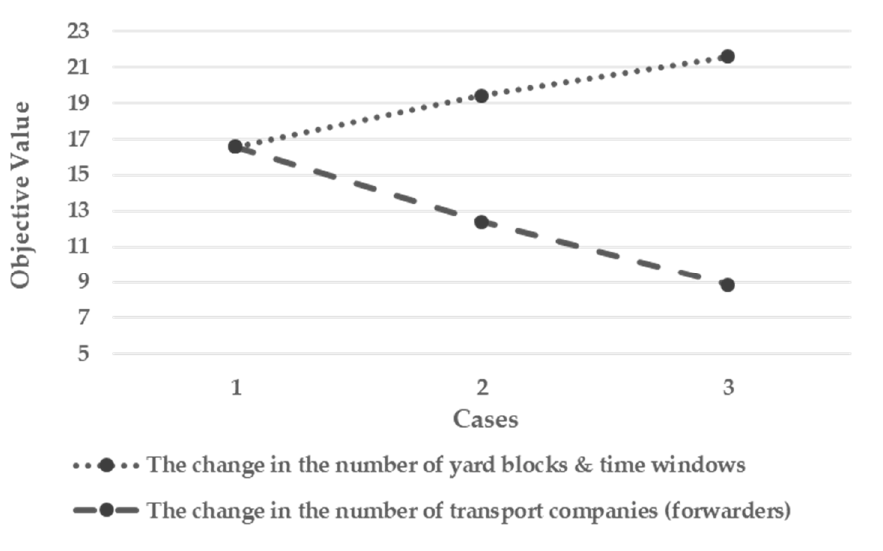
Figure 8. The relationship between the terminal operator and the change in the number of yard blocks, time windows, and transport companies (forwarders).